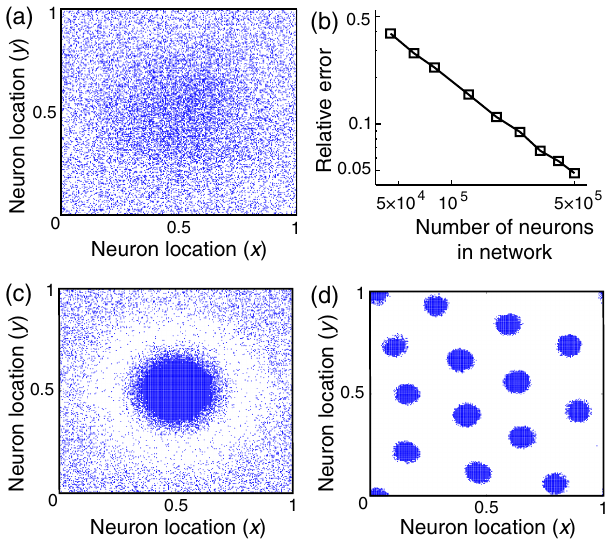
VIDEO 1. Two-dimensional network simulations. (a) Raster plot of excitatory neuron spikes from a two-dimensional network 0 . 2 and σ σ 0 . 1 , so that a stable simulation with σ o ¼ e ¼ i ¼ . 25 × 10 5 neurons. (b) The relative mean-square difference